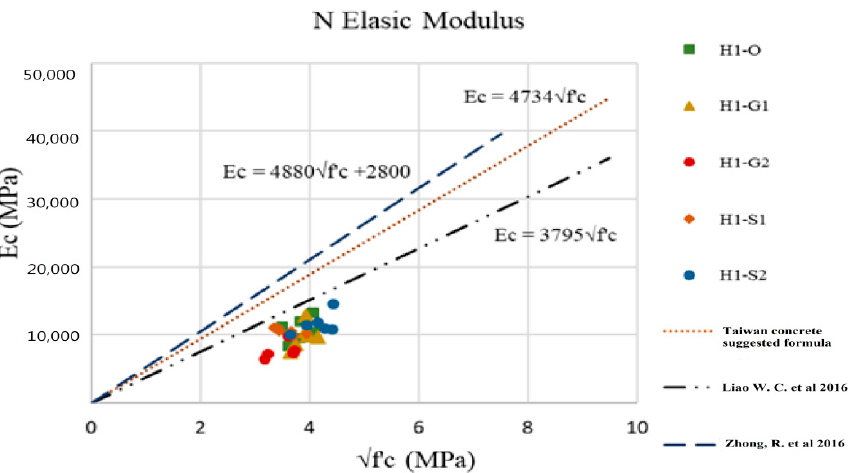
Figure 7. Elastic modulus distribution diagram for ordinary-strength pervious concrete specimens.